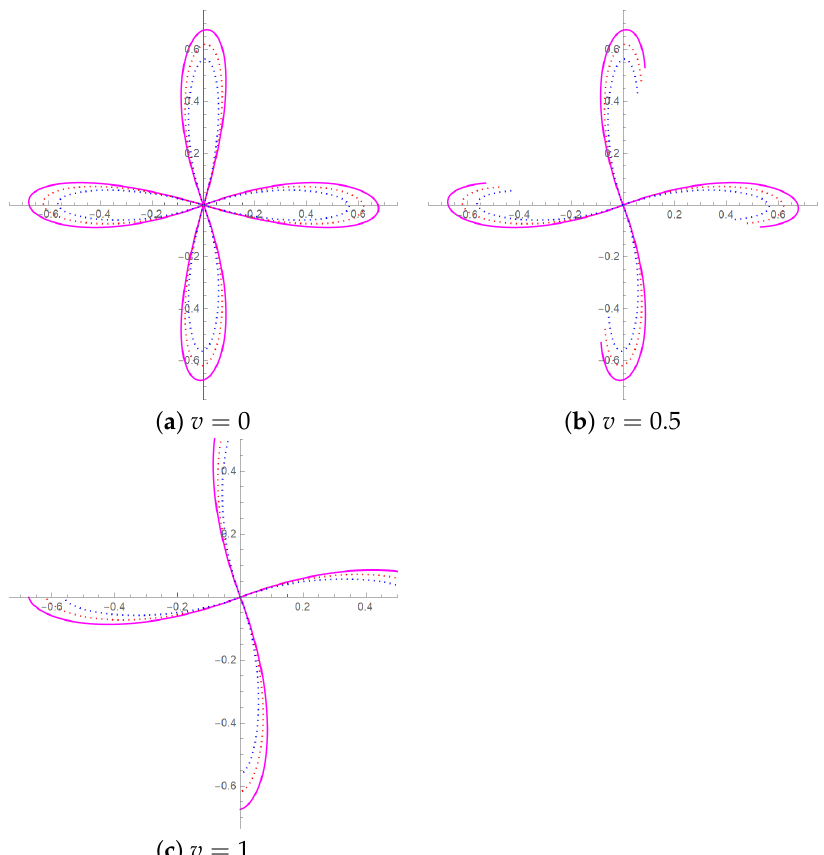
Figure 17. Modelling shape of petal using cubic fractional Bézier curve with different shape parame- ters and fractional